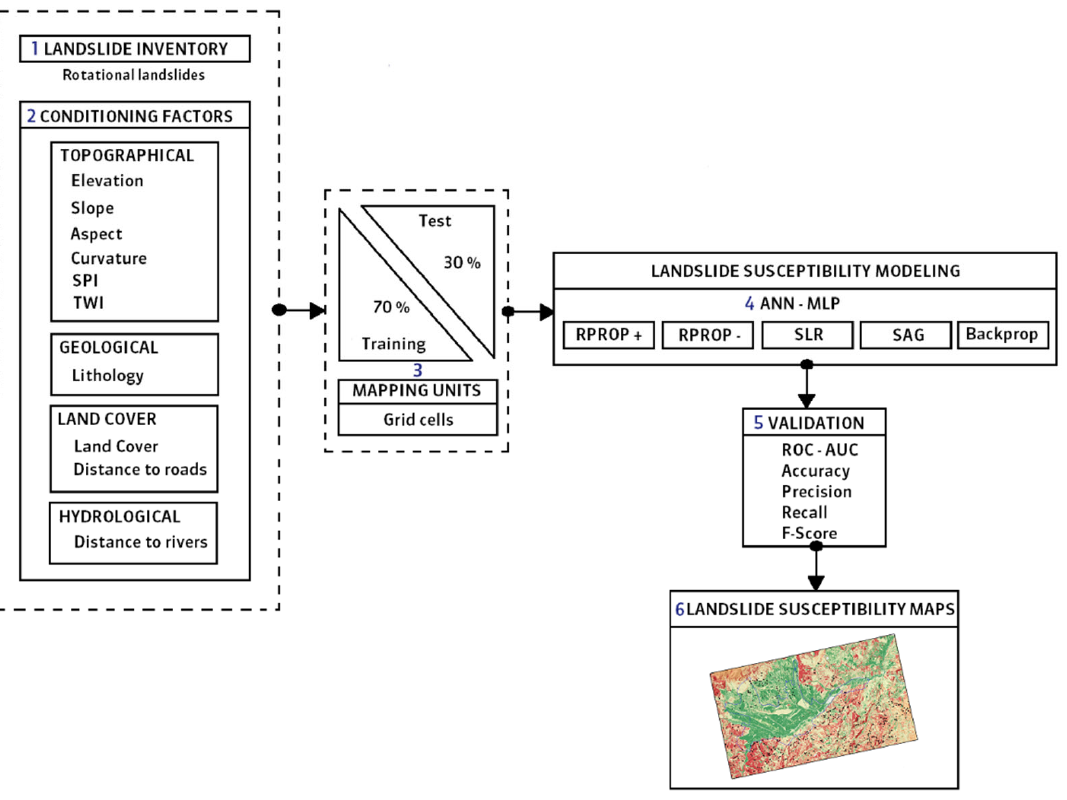
Figure 2. Diagram of methodology implemented to obtain landslide susceptibility maps.